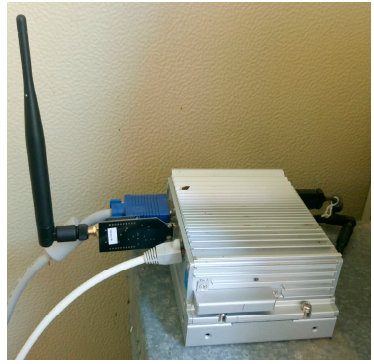
Figure 4. Local database server.